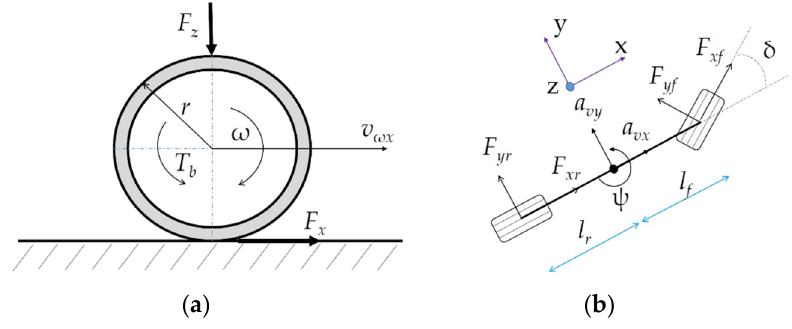
Figure 1. Vehicle model schematic drawing: ( a ) single ‐ wheel model; ( b ) single ‐ track